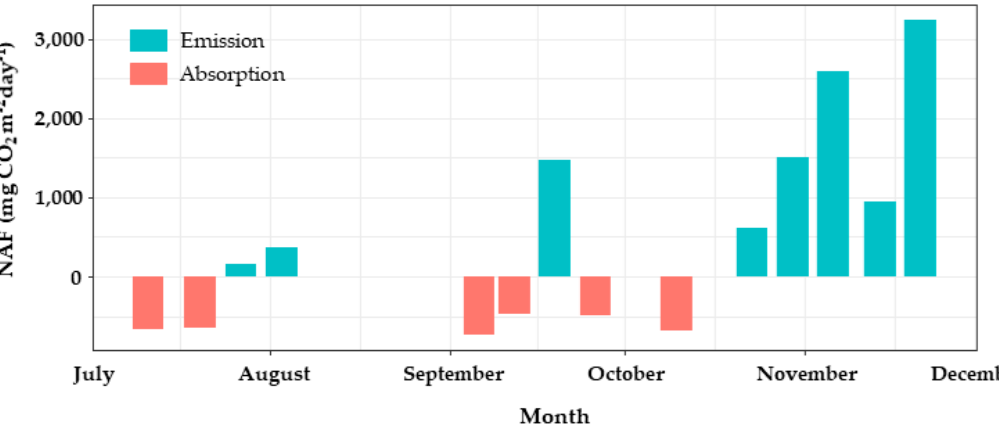
Figure 8. Temporal variations of CO 2 net atmospheric flux (NAF) during the monitoring period. Negative and positive values indicate absorption and emission of CO 2 , respectively.